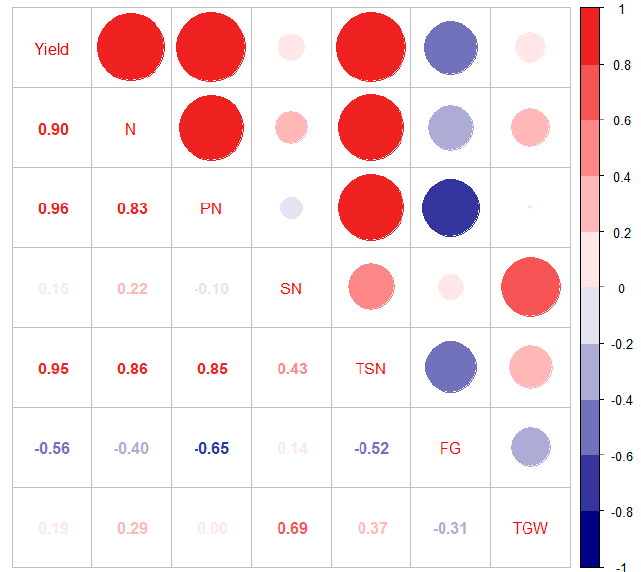
Figure 3. Correlation analysis among yield components, N uptake, and biomass at maturity (R 0.05 = 0.576 and R 0.01 = 0.707). N: N uptake at maturity; PN: panicles number; SN: spikelets number per panicle; TSN: total spikelet number per m 2 ; FG: filled grain percentage; GW: grain weight.